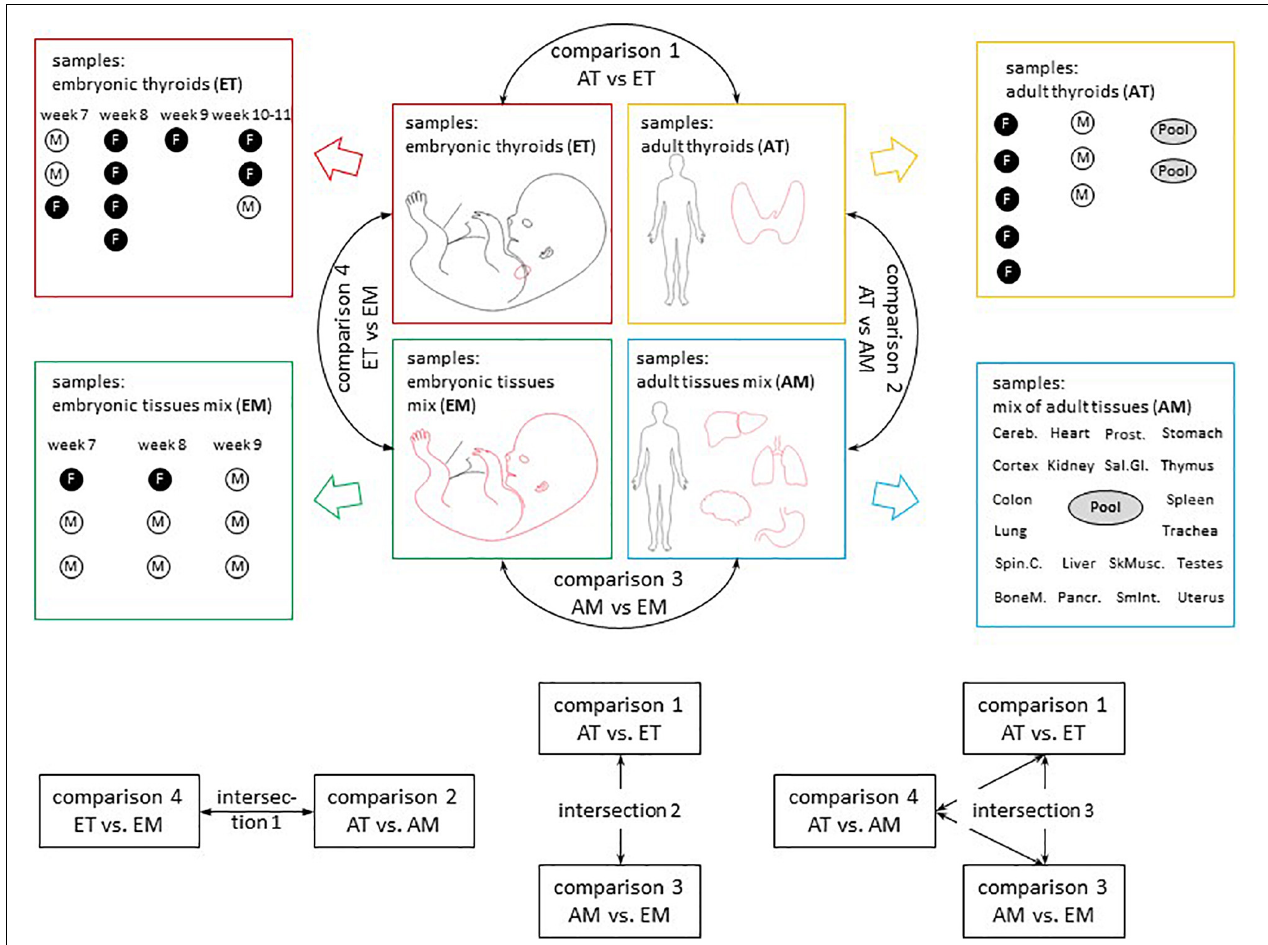
FIGURE 2 | Overview of transcriptomic analyses. Sample composition of the four transcriptomic datasets used in the study (AT, ET, AM, and EM) and comparisons between them. Comparison 1 (AT vs. ET) addressed changes in gene expression observed in the course of thyroid maturation. Comparison 2 (AT vs. AM) and comparison 4 (ET vs. EM) allowed to reveal transcriptional signatures of adult and embryonic thyroids respectively. Comparison 3 (AM vs. EM) addressed changes in gene expression observed in the course of non-thyroid development. M, male. F, female. Week, gestational week. M, male. F, female. Embryonic thyroids (ET) and Adult thyroids (AT): this study. Embryonic tissues mix (EM): Yi et al. (2010), GSE15744. Adult tissues mix (AM): Tateno et al. (2013), GSE